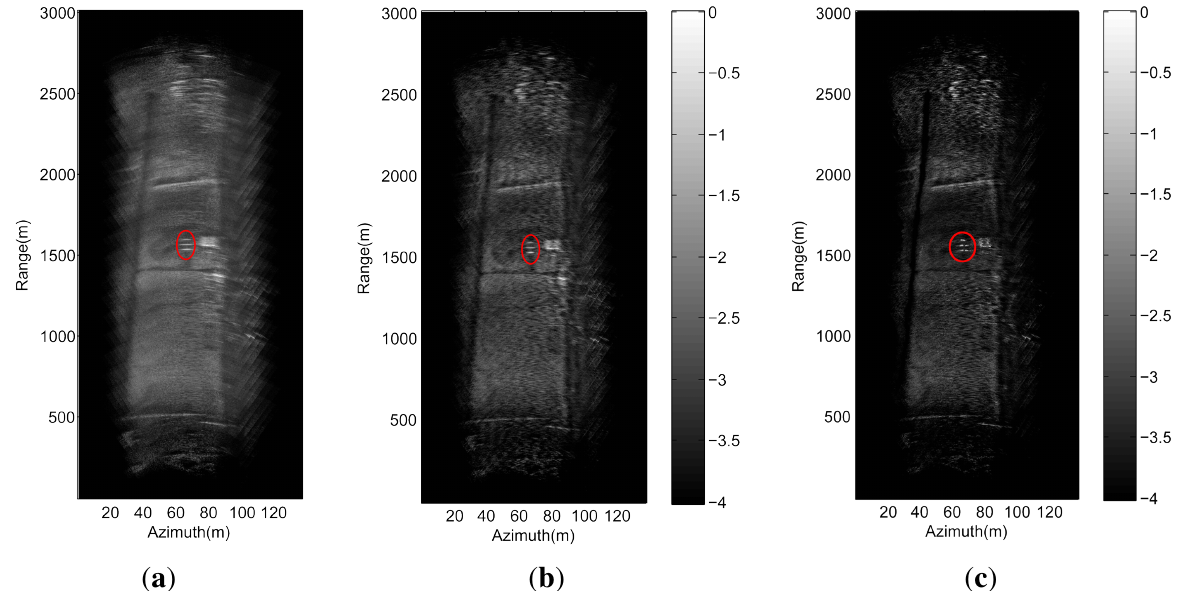
Figure 10. Angular super-resolution imaging results. ( a ) Real beam scanning radar imaging; ( b ) Experimental data processed by Guan’s method; ( c ) Experimental data processed by the proposed